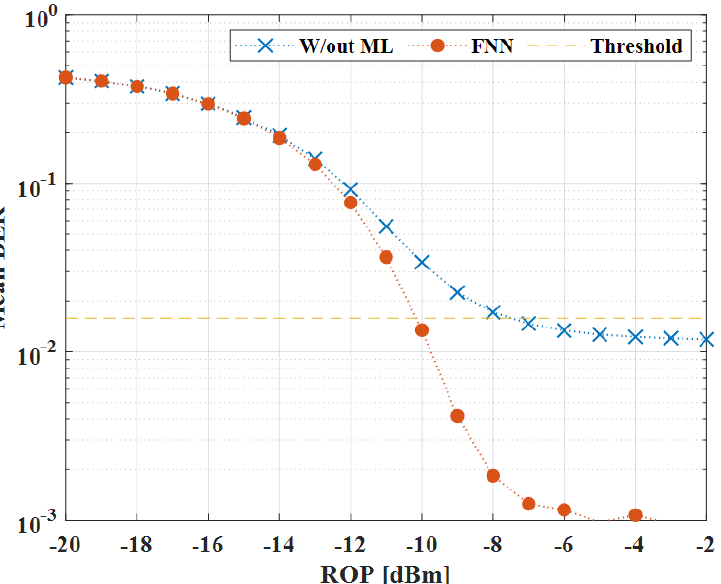
Figure 10. Mean BER as a function of the received optical power using FNN (circles) and without the use of ML (crosses).